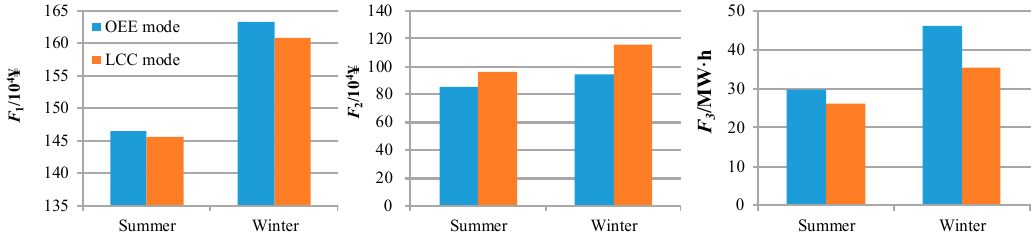
Figure 8. The different objective values under the comprehensive objective function on typical days.